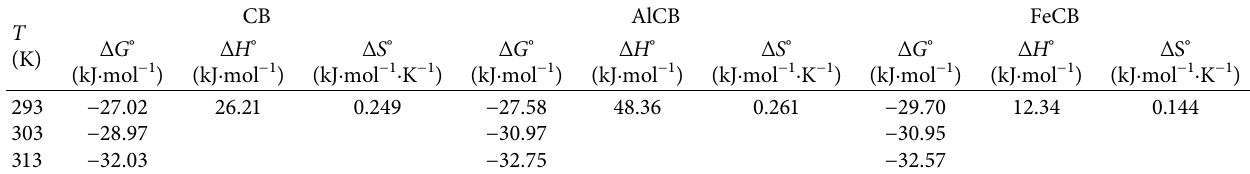
Table 5: Thermodynamic parameters for the phenol red adsorption onto CB, AlCB, and